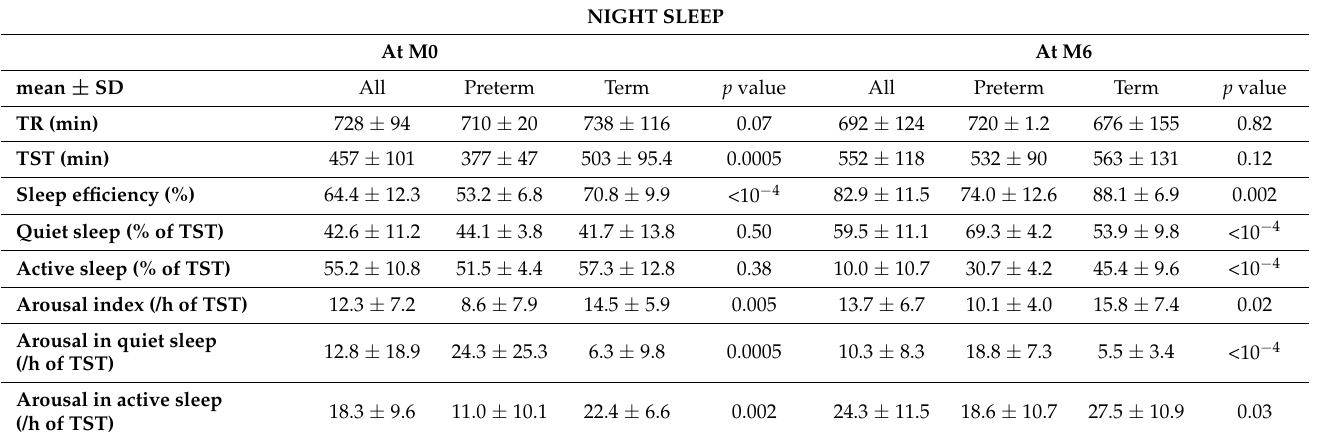
Table 2. Sleep and arousal characteristics during day and night for term and preterm babies at M0 and M6